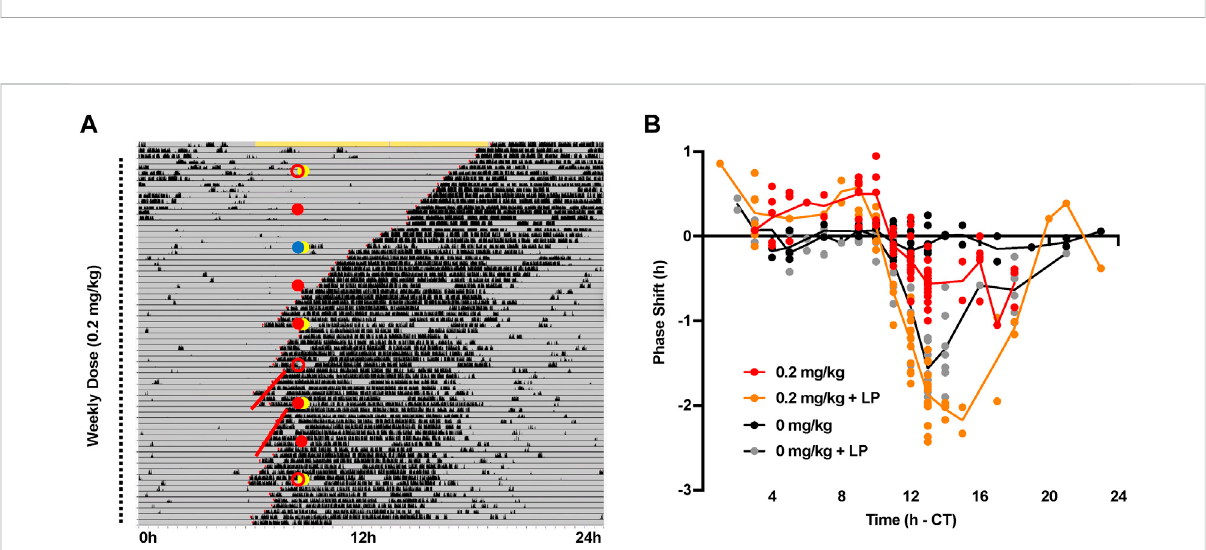
FIGURE 3 Phase response curve to CT1500 with and without a simultaneous light pulse. (A) C57Bl6/J ( n = 40) male adult mice were housed in constant dark, representative actogram shown. Grey indicates darkness, black bars are wheel running activity. At each dot (10 am), the mice received